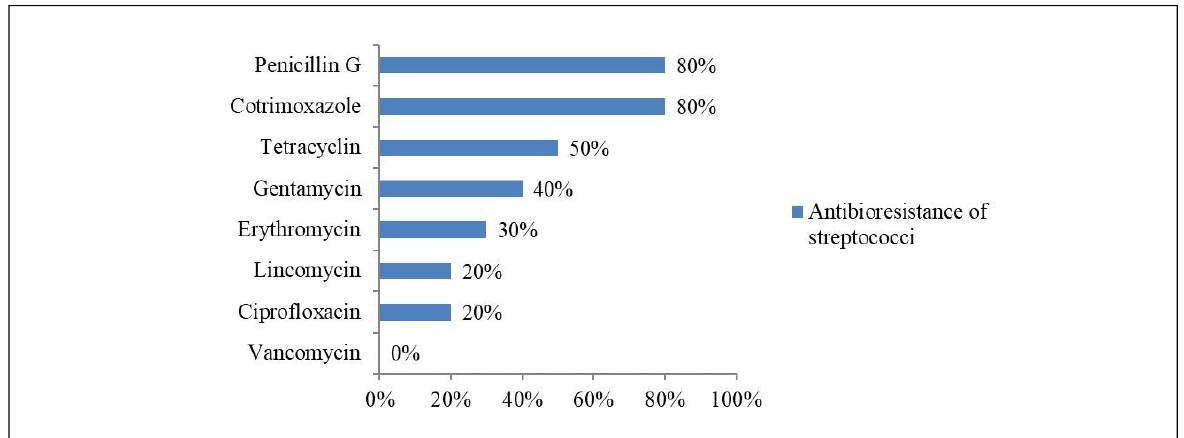
Figure 2: Antibiotic resistance of NFGNB Concerning the isolates of streptococci, the antibiotic resistance varies from 0% (vancomycin) to 80% (penicillin G) (Figure 3).